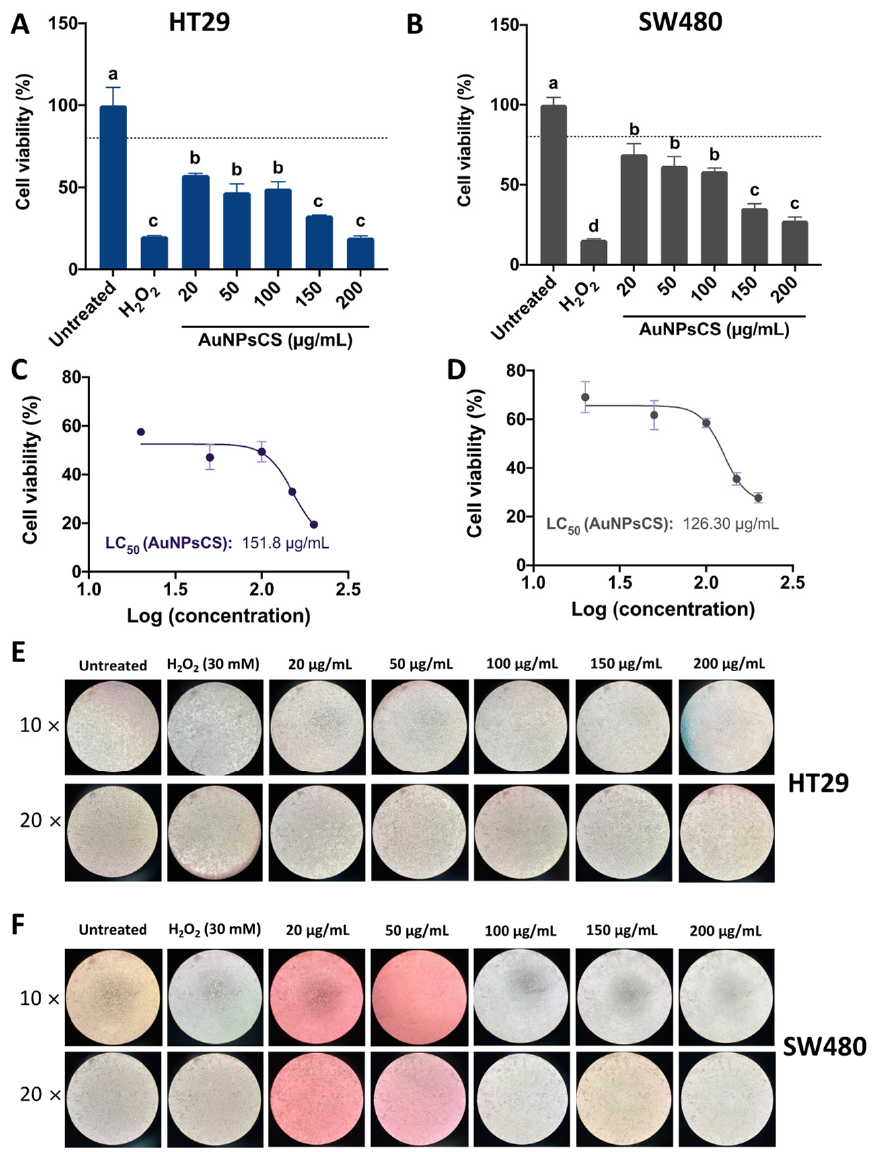
Figure 6. Impact of gold nanoparticles made by chemical synthesis (AuNPsCS) on HT29 and SW480 cells viability. ( A ) Effect of AuNPsCS in HT29 cells viability; ( B ) Influence of AuNPsCS in SW480 cells viability; ( C ) Quantified IC 50 of AuNPsCS treatments on HT29 cells; ( D ) Quantified IC 50 of AuNPsCS treatments on SW480 cells; ( E ) Representative pictures (10 × and 20 × ) of AuNPsCS impact on HT29 cells; ( F ) Representative pictures (10 × and 20 × ) of AuNPsCS impact on SW480 cells. Hydrogen peroxide (H 2 O 2 )-treated cells (30 mM) were used as a positive control. Untreated cells (DMEM + 0.5% ASB) were used as a negative control. Pictures from untreated controls were the same as AuNPsME and AuNPsCE. For Figure 6A,B, different letters (a, b, c, d) express significant differences ( p < 0.05) by Tukey-Kramer’s test. The dashed line in ( A , B ) represent 80% cell viability. AuNPsCS have been tested in colorectal cancer cell lines, exhibiting viabilities <80% in HT29 and SW480 cells at 1–200 µM concentrations, although HT29 cells displayed lower cell viabilities than SW480 [59], similar to the results presented in this research. It